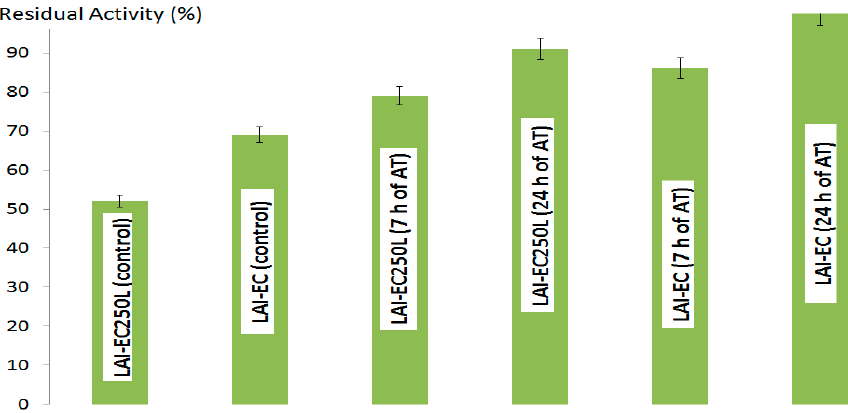
Figure 3. Thermal stability of L -arabinose ( D -galactose) isomerase (LAI) derivatives onto Eupergit C (EC) and Eupergit C 250 L (EC250L) with alkaline treatment (AT) and blocking with glycine. Derivatives were incubated for 30 h at 60 °C and residual activities were determined. Control derivatives were only blocked but did not receive alkaline treatment after immobilization.